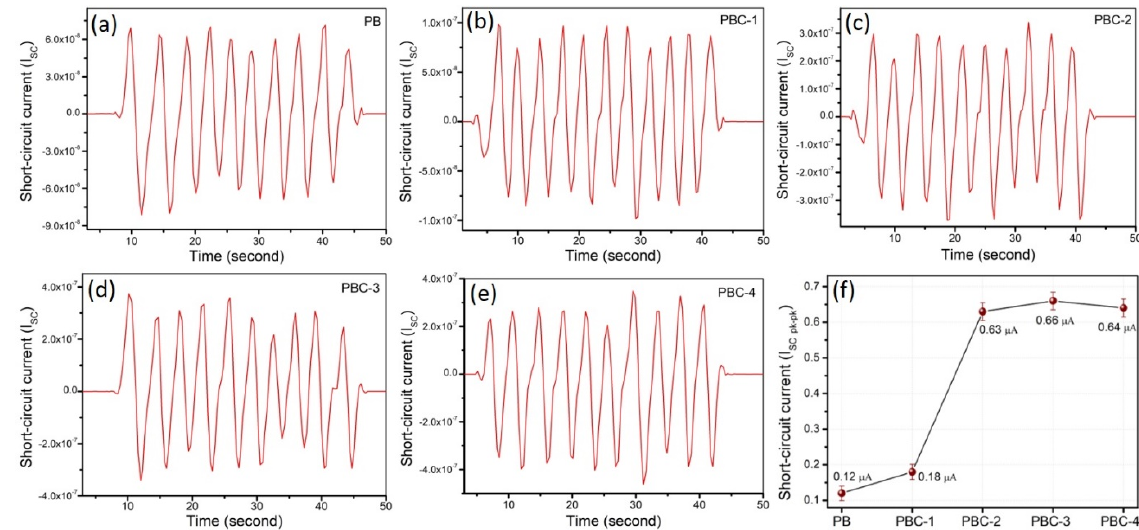
Figure 8. Short ‐ circuit current of PB and PBC films: ( a ) PB; ( b ) PBC–1; ( c ) PBC–2; ( d ) PBC–3; ( e ) PBC–4; and ( f ) overall peak ‐ to ‐ peak output current.